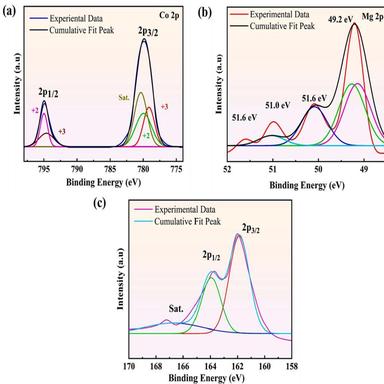
XPS examination of (a) Co, (b) Mg, (c) S.